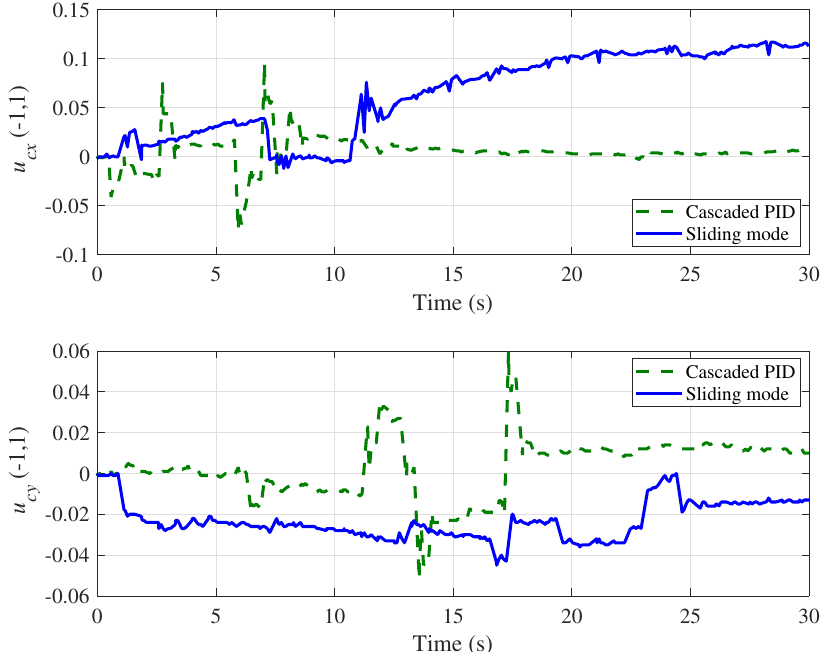
Figure 17. Normalized control inputs of azimuth gimbal and elevation gimbal in experimental